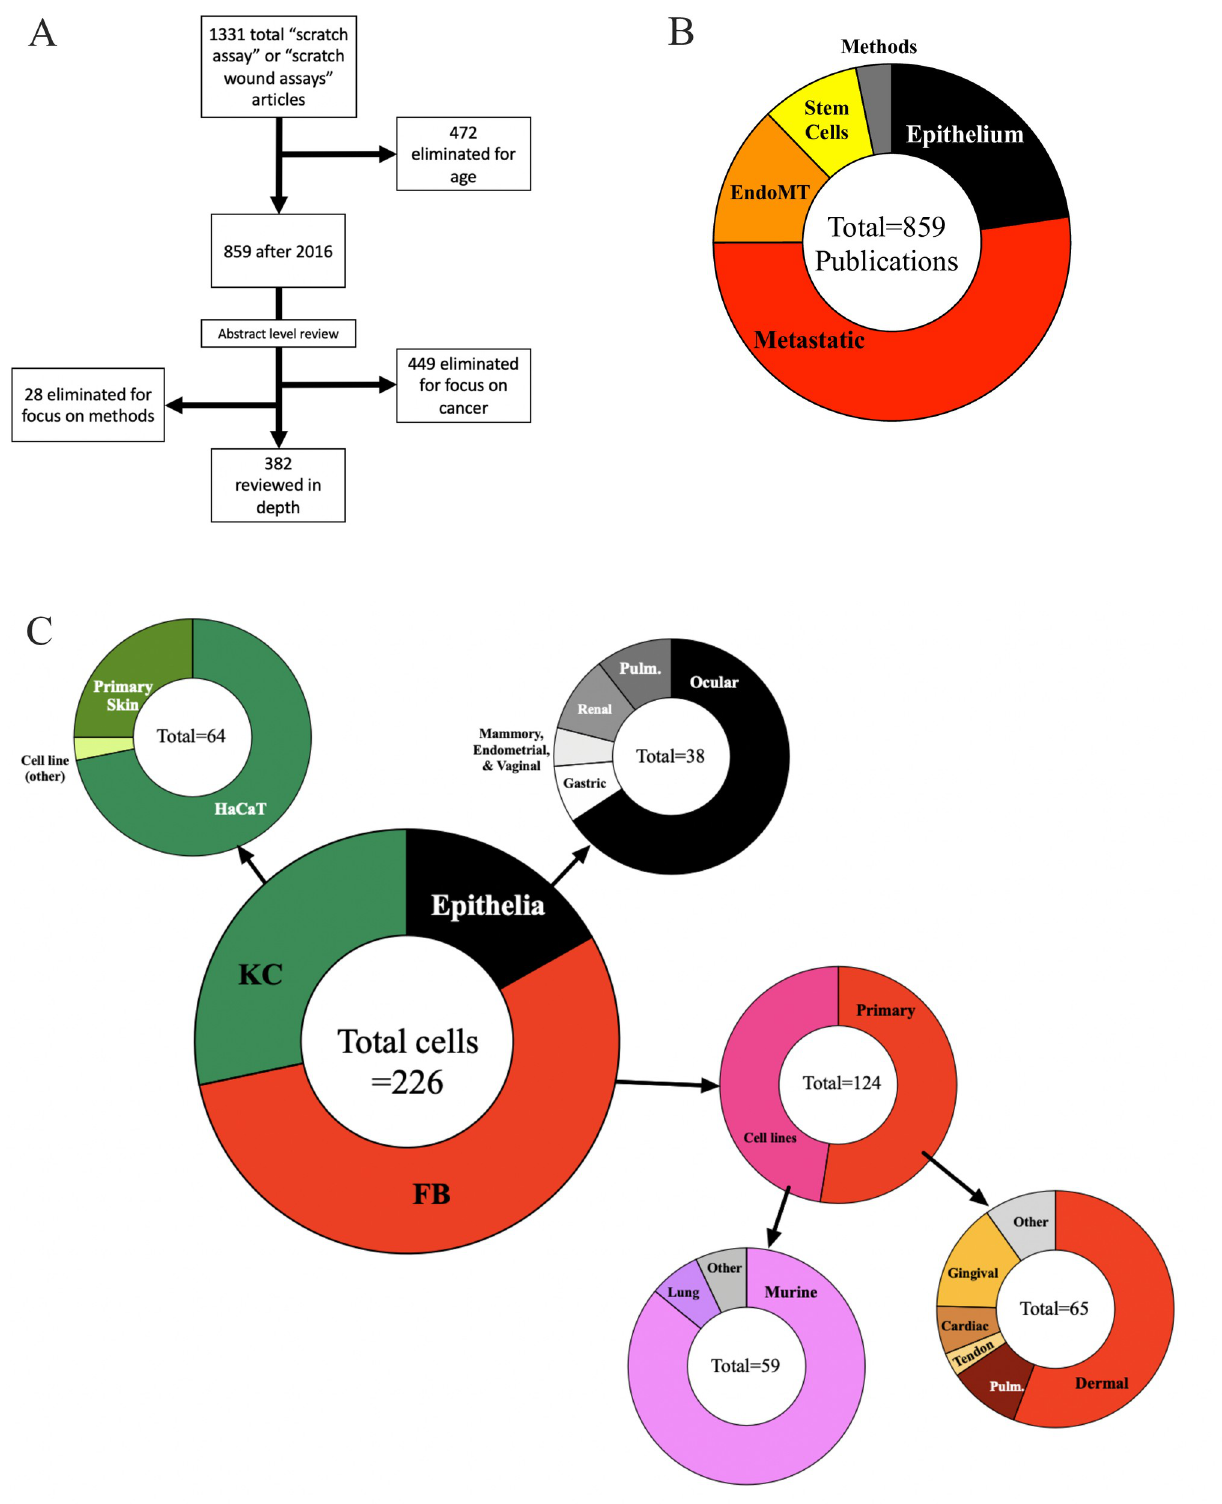
Fig 1. Articles using the scratch assay vary by cell type. (A) Progression and enumeration of articles found during qualitative literature review. (B) Pie chart of the total articles uncovered separated by general wound healing (often EMT) type or EndoMT. (C) Pie chart breakdown of total cell types used in the identified literature. KC = keratinocyte; FB = fibroblasts. EMT does not definitionally occur in FB, which are already of the mesenchymal phenotype.